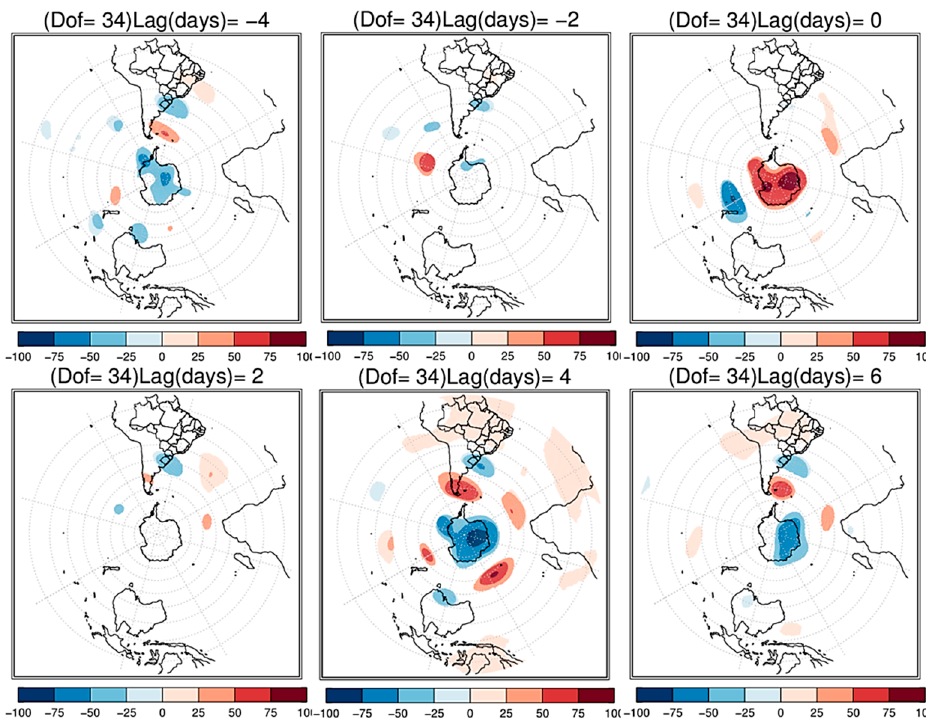
Figure 14. The same as Figure 13 but for AAO–.